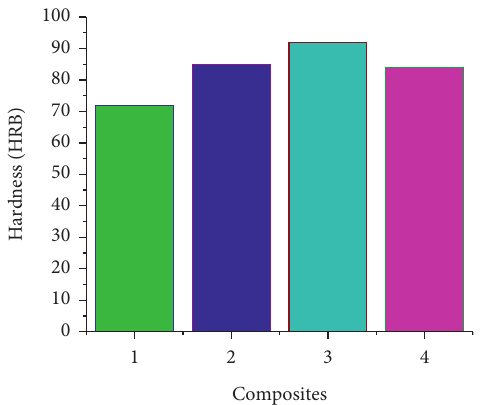
Figure 5: Hardness of various composites. (1) Mg alloy, (2) coated Al 2 O 3 , (3) coated SiC, and (4) coated Al 2 O 3 + SiC.